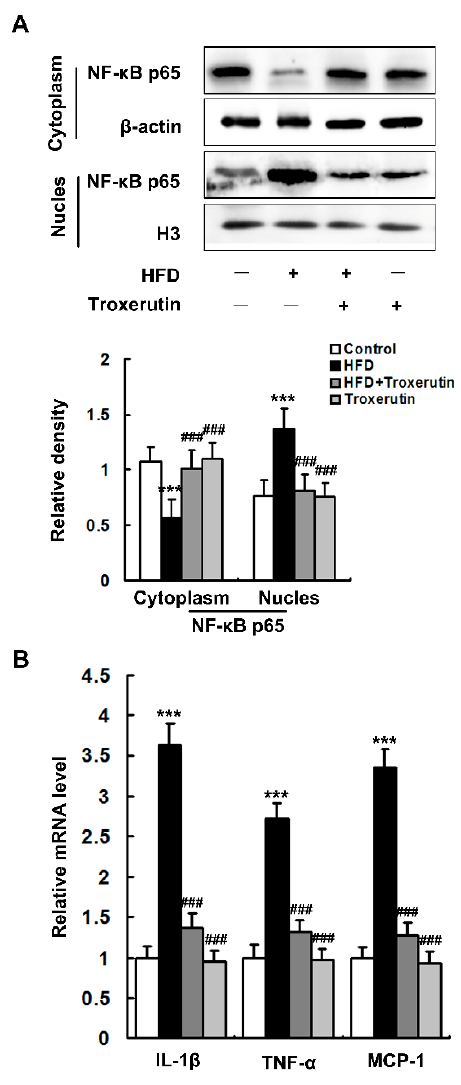
Figure 3. Troxerutin inhibits inflammatory response in the HFD ‐ treated mouse livers ( n = 3). ( A ) Immunoblotting and densitometry of nuclear and cytoplasmic NF ‐κ B p65 in mouse livers; ( B ) The mRNA level of inflammation ‐ related genes in mouse livers. All of the values are expressed as the mean ± SD. *** p < 0.001 vs. the control group; ### p < 0.001 vs. the HFD